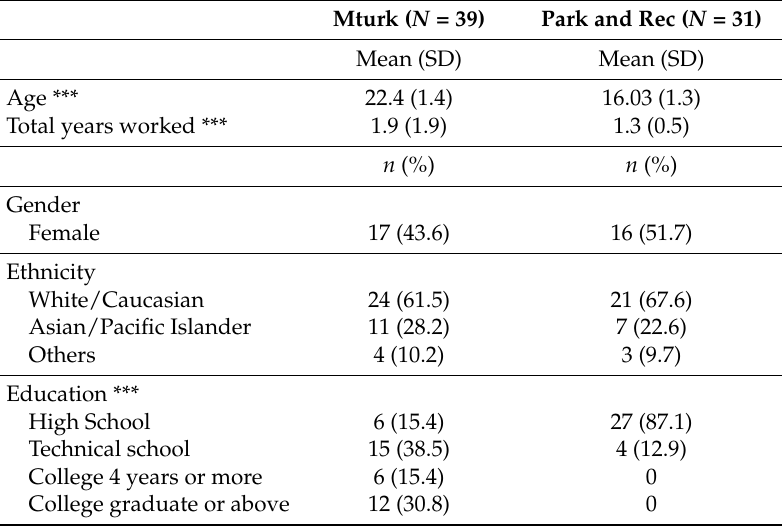
Table 1. Demographic